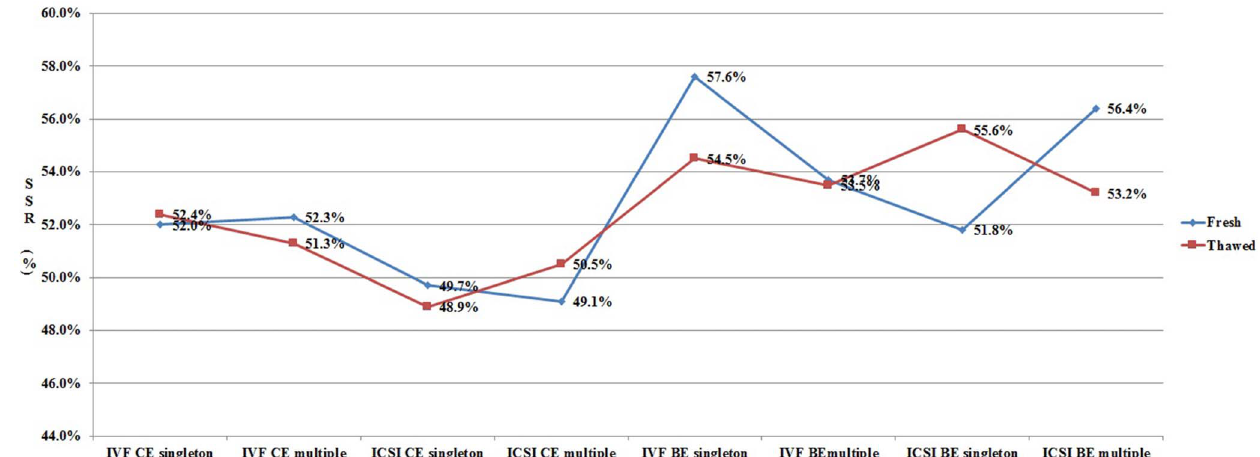
Figure 3. Effect of type of embryo transferred (fresh/thawed) on SSR. SSR= secondary sex ratio; IVF= in vitro fertilization; ICSI= intracytoplasmic sperm injection; CE= cleavage stage embryo; BE= blastocyst embryo.